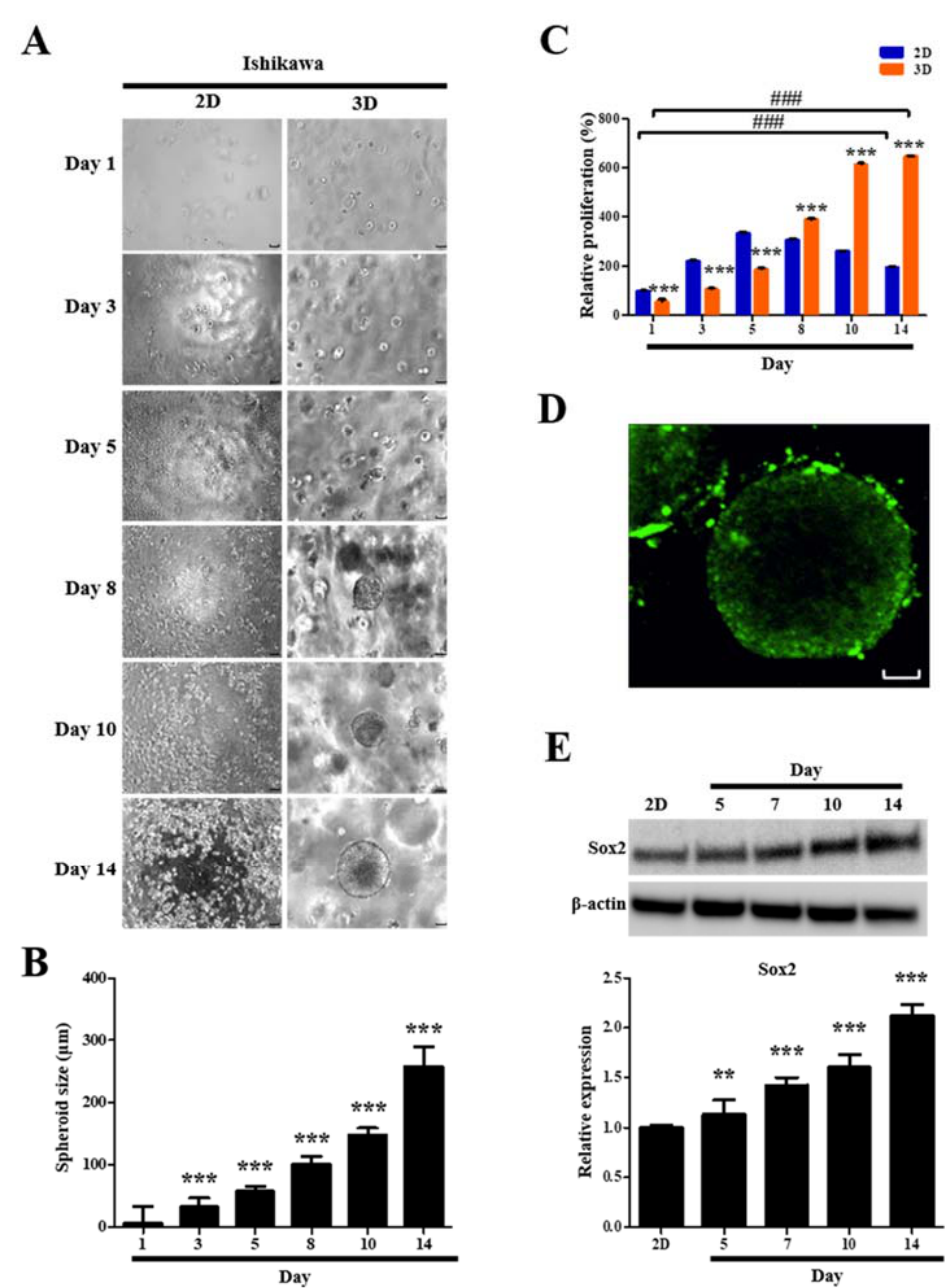
Figure 10. Formation and growth of human endometrial epithelial cell spheroids in standard plastic tissue culture plates and hydrogels. ( A ) Photomicrograph (100 × ) under a phase contrast microscope showing images of 2D- and 3D-cultured cells with time; ( B ) diameters of cell spheroids depicted in a bar graph; ( C ) CCK-8 cell proliferation assay of 2D- and 3D-cultured cells; ( D ) representative fluorescence microscopic image (400 × ) of 3D-cultured cells on day 14 as determined using live–dead cell viability assay (Green, calcein: live cells; red, EthD: dead cells). ( E ) SOX2 protein level increased time-dependently in 3D-cultured cells, as detected by Western blotting. β -actin was used as the internal loading control for Western blot analysis data normalization. All data are expressed as relative values against their respective control group. Data represent the mean ± standard deviation of three independent experiments. ** p < 0.01 and *** p < 0.001; ### p < 0.001. Scale bars = 50 µ